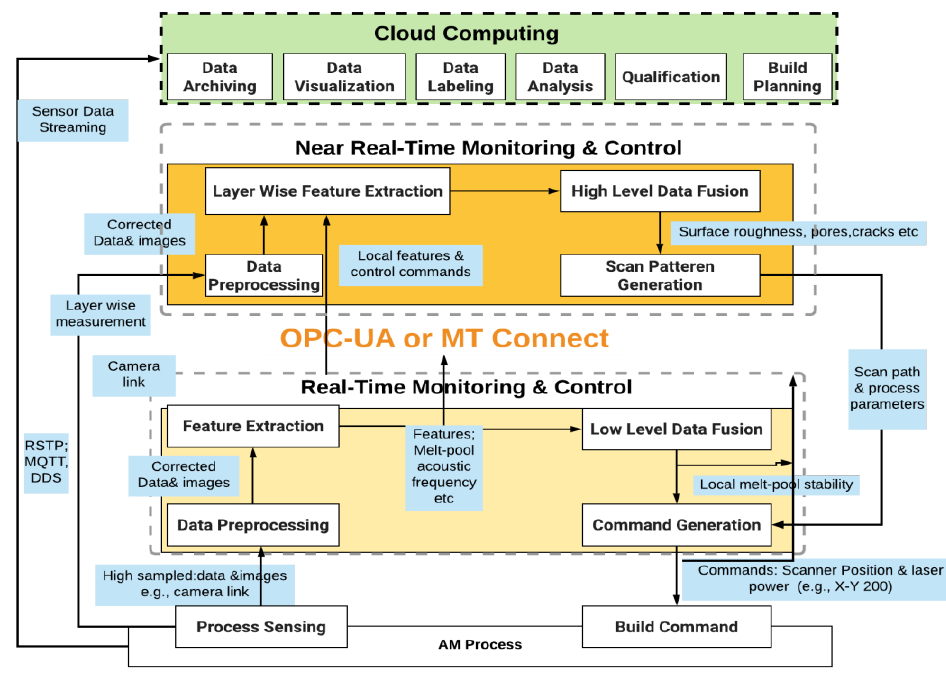
Figure 3. Interfaces linking function blocks.